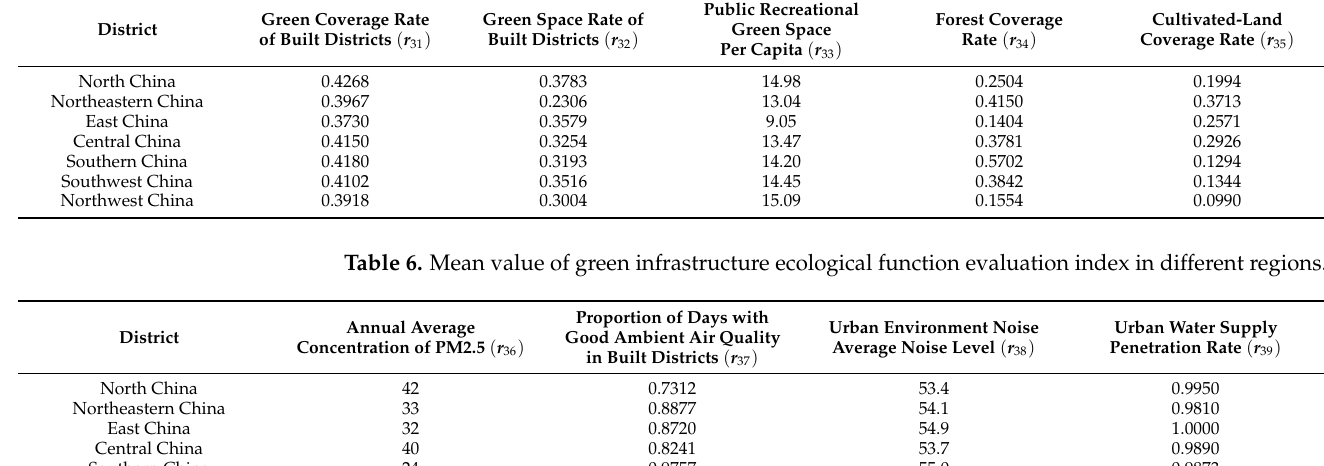
Public Recreational Forest Coverage Green Space Rate ( r 34 ) Per Capita ( r 33 )